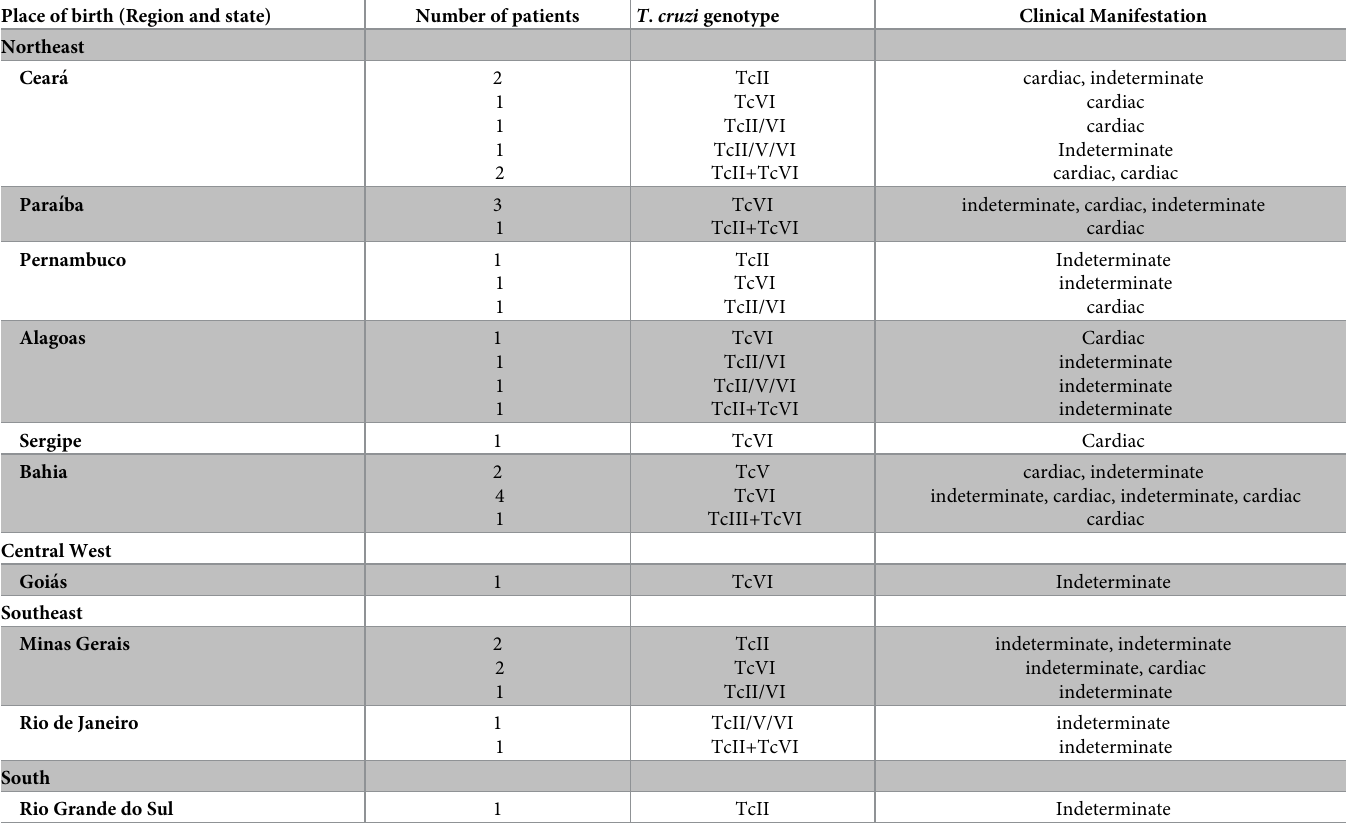
Table 4. Geographic distribution of T . cruzi DTUs in the patient samples analyzed. Place of birth (Region and